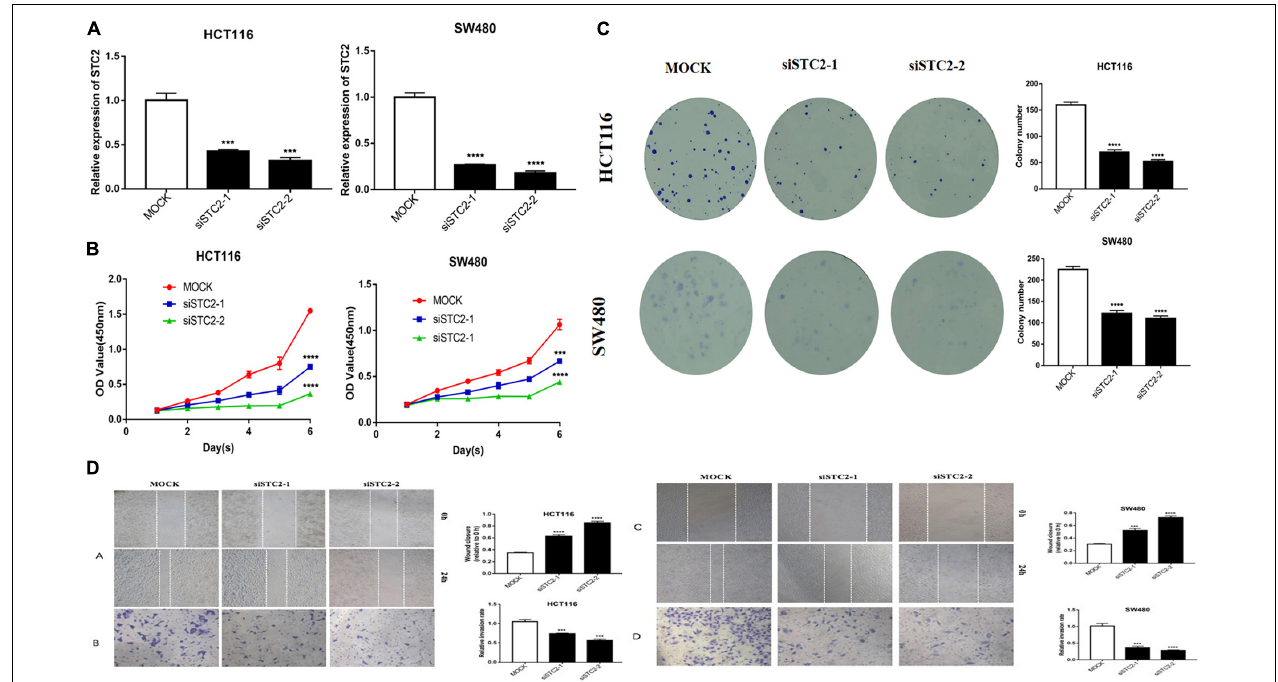
FIGURE 11 | STC2 knockdown inhibits cell proliferation, migration, and invasion in vitro . (A) STC2 expression in STC2-siRNA HCT-116 and SW-480 cells. (B) Growth curves for HCT-116 and SW-480 cells after transfection with STC2 siRNA determined by Cell Counting Kit-8 (CCK-8) analysis. (C) Clonogenic assay on STC2-siRNA knockdown HCT-116 and SW-480 cell lines showing decreased colony formation compared with the negative control. (D) Decreased cell migration and Transwell invasion activity in STC2-siRNA knockdown HCT-116 and SW-480 cells. Results are expressed as mean ± SEM. Significance difference was tested by one-way ANOVA: *** p < 0.001 versus mock, **** p < 0.0001 versus